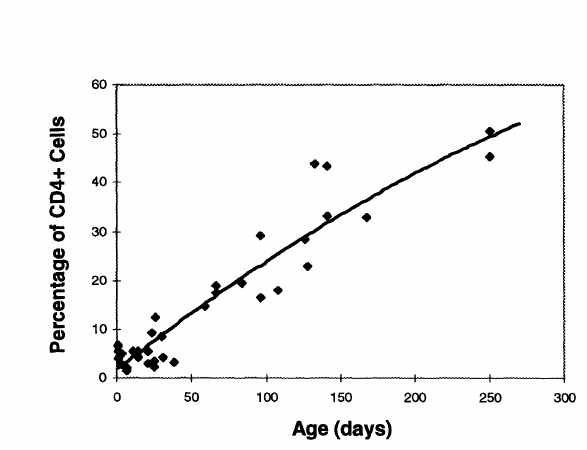
FIGURE 4 Change in CD4 expression with age. IEL were isolated from Sprague-Dawley rats between 0 and 250 days old. After stain- ing with a monoclonal antibody to CD4, IEL were analyzed by flow cytometry. First degree polynomial regression was used to generate the best fit line